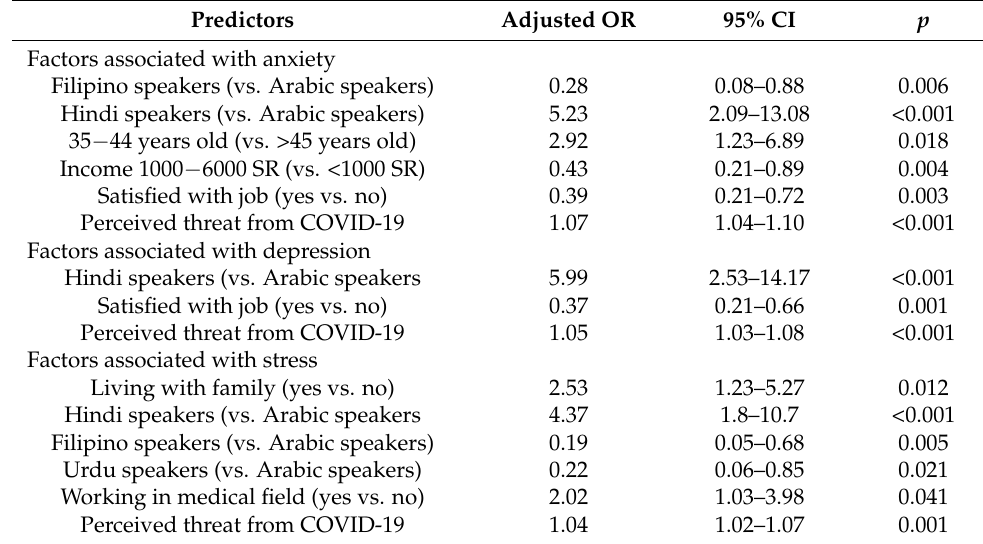
Table 4. Multivariate logistic analysis results for depression, anxiety, and